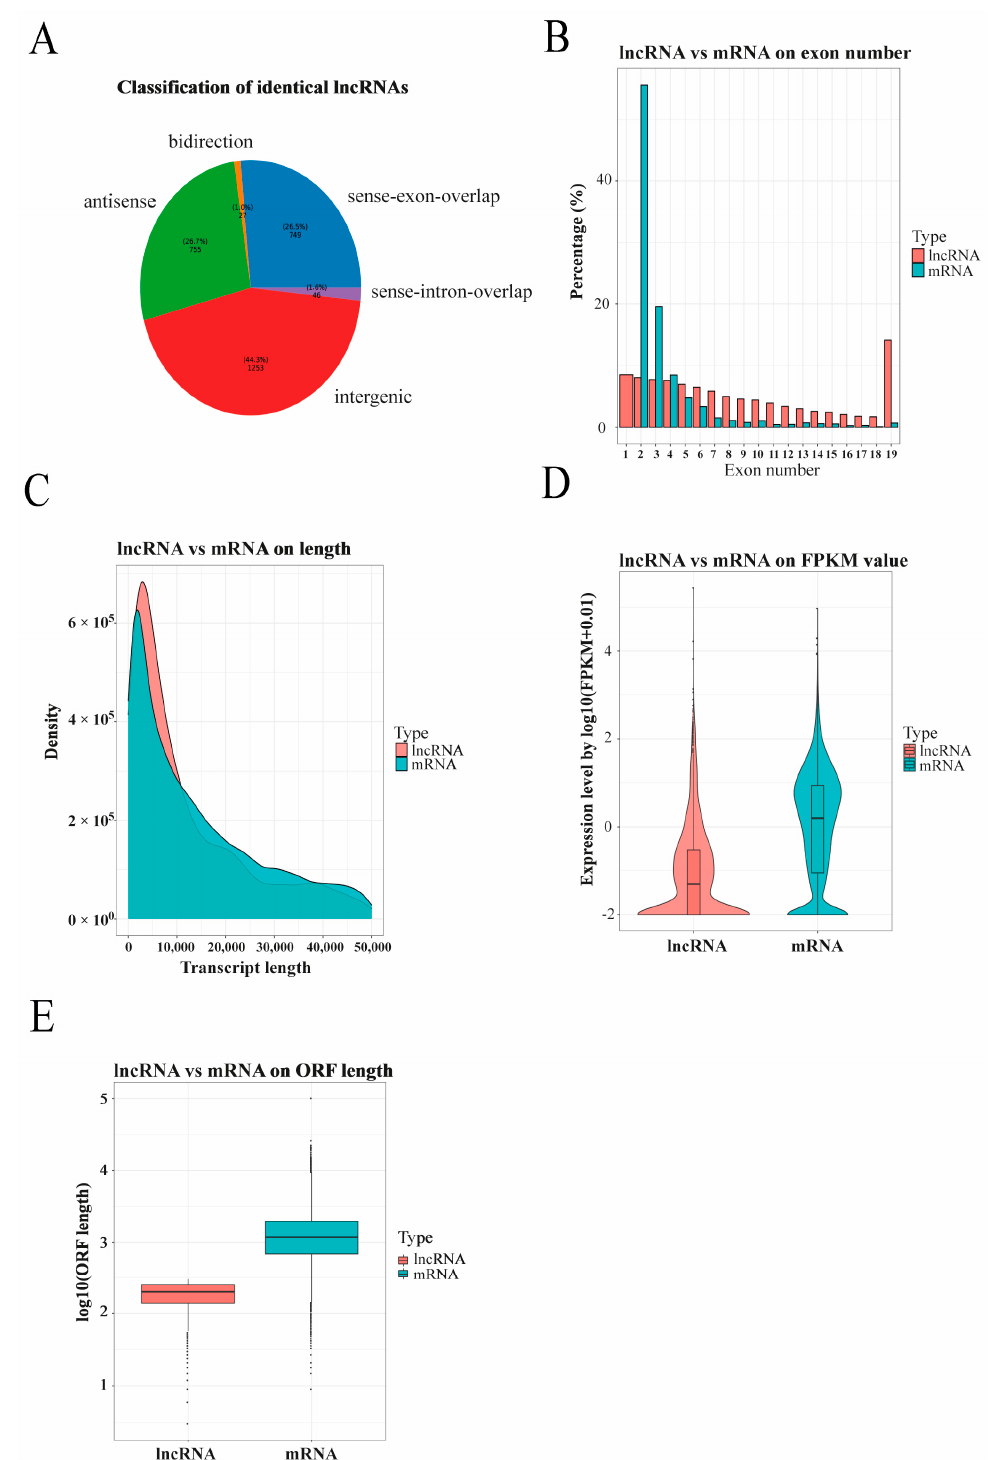
Figure 1. Genomic characterization and ( A ) classification of lncRNAs. lncRNA and mRNA transcripts were compared by ( B ) exon number, ( C ) length, ( D ) fragments per kilobase of exon per million mapped reads (FRKM) value, and ( E ) open reading frame (ORF) length.